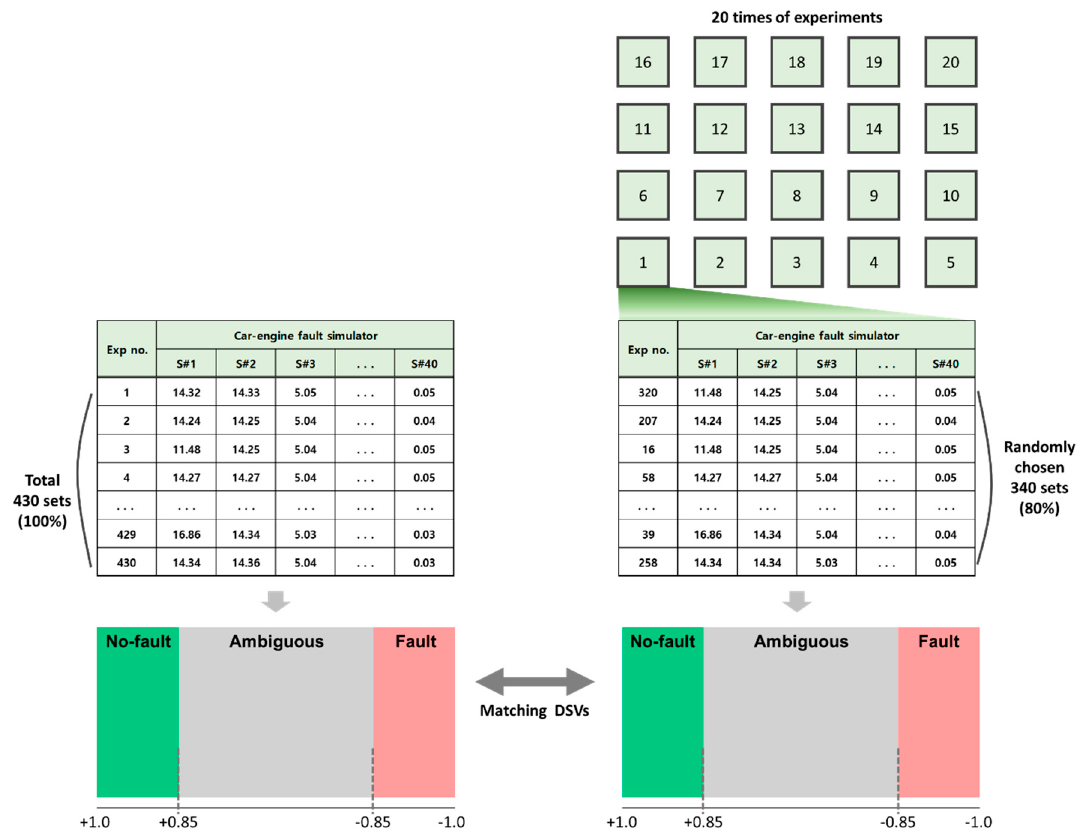
Figure 7. Experiment procedure for 20 repeated experimental trials.